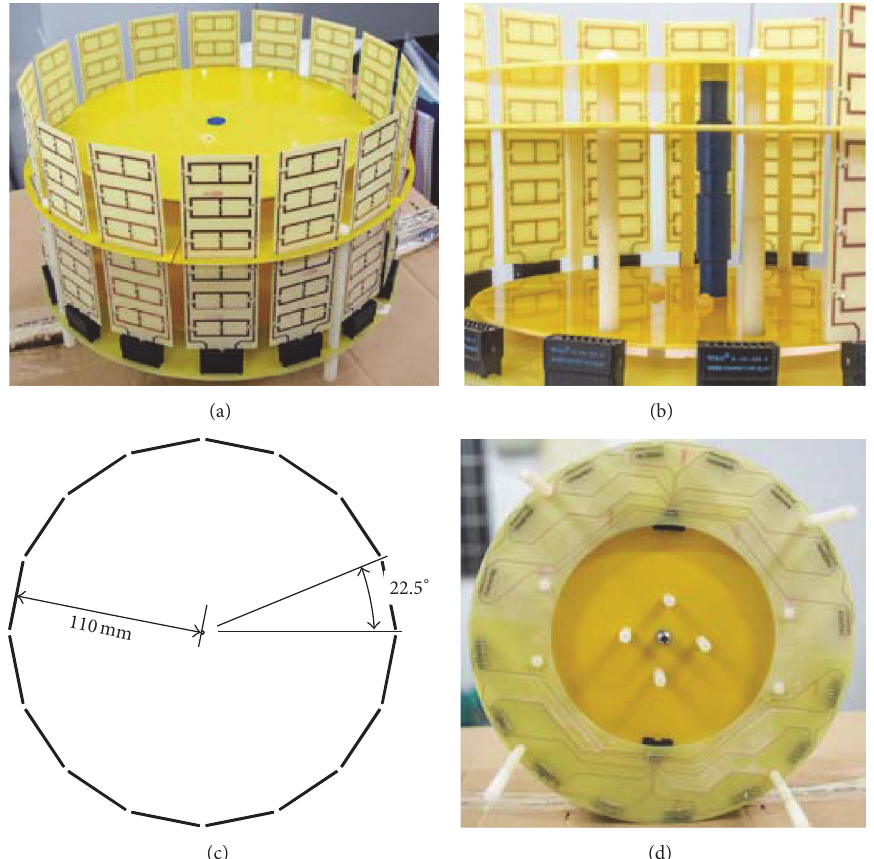
Figure 1: Antenna structure. (a) Photo of the antenna. (b) Central dipole antenna. (c) Cross section and dimensions. (d) Bottom